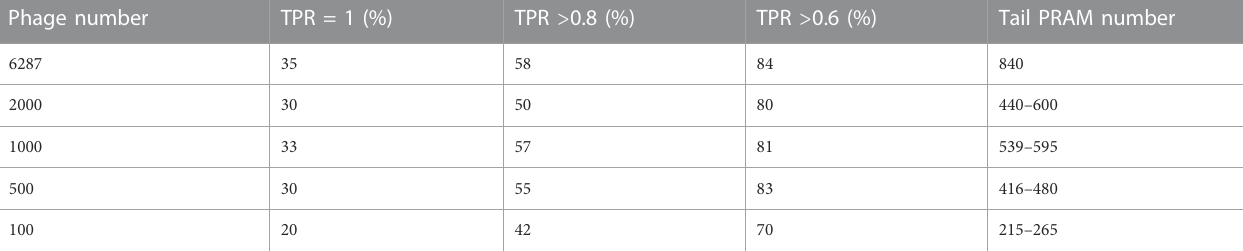
TABLE 3 True-positive rate (TPR) of tail protein prediction models trained with a reducing number of phages.